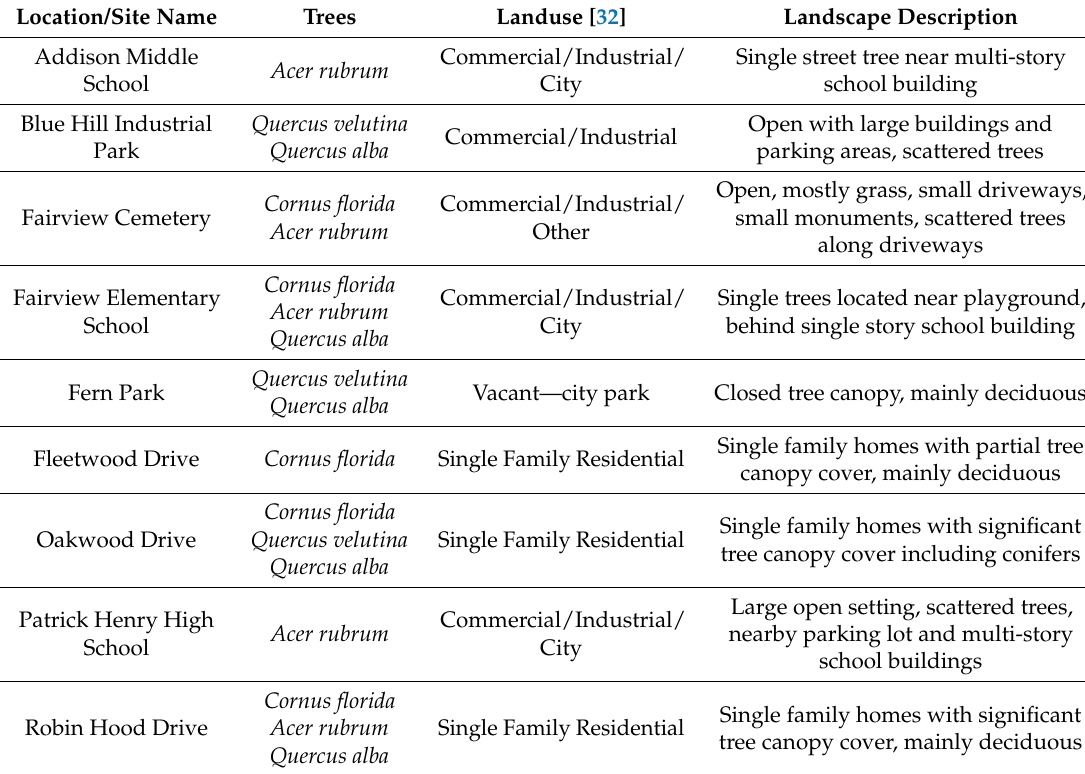
Table 1. Site name including trees, landuse, and surrounding landscape